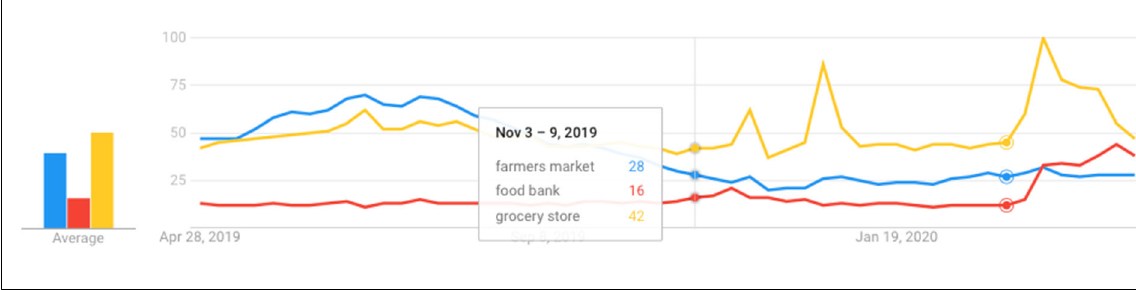
Source: Google Trends, April 27, 2020; the geography of search is the U.S.; circles to the right show week of March 1–7, 2020. 5. Despite growing interest in local, demand for breweries and wineries has dramatically